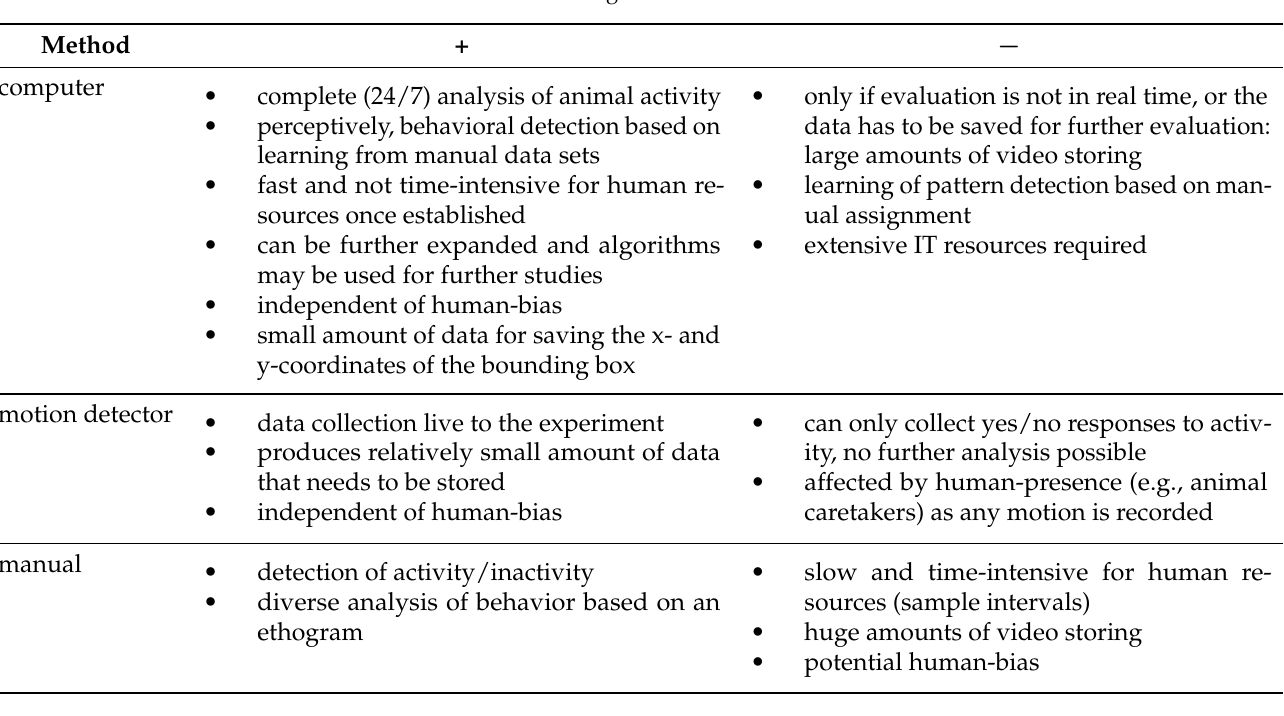
( a ) Blind spot areas of the cameras without changed camera ( b ) Blind spot area of the motion detector. angle due to the foxes. Red: Blind spot of the right camera. Green: Blind spot of the motion detector. Blue: Blind spot of the left camera. Figure 12. Estimated blind spot areas of the cameras and the infra-red motion detector. Table 4. Potential benefits and disadvantageous of the three different evaluation